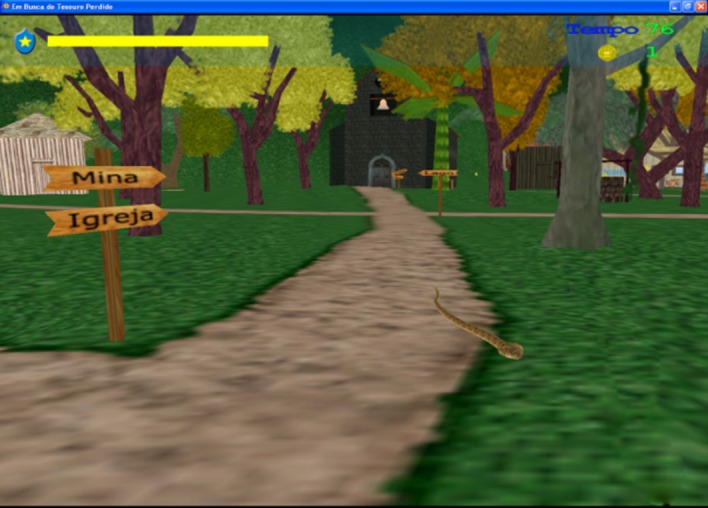
External Environment [6].